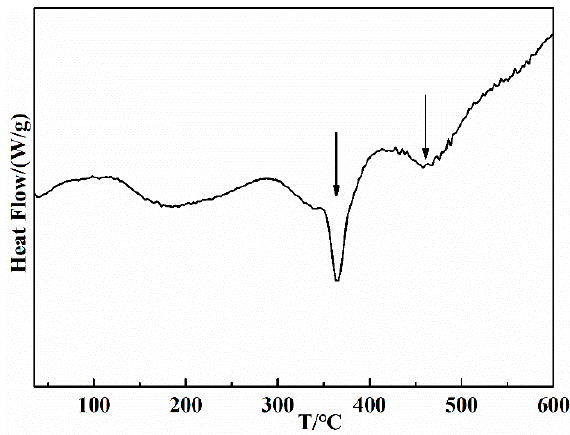
Figure 4. DSC curve of NiP.